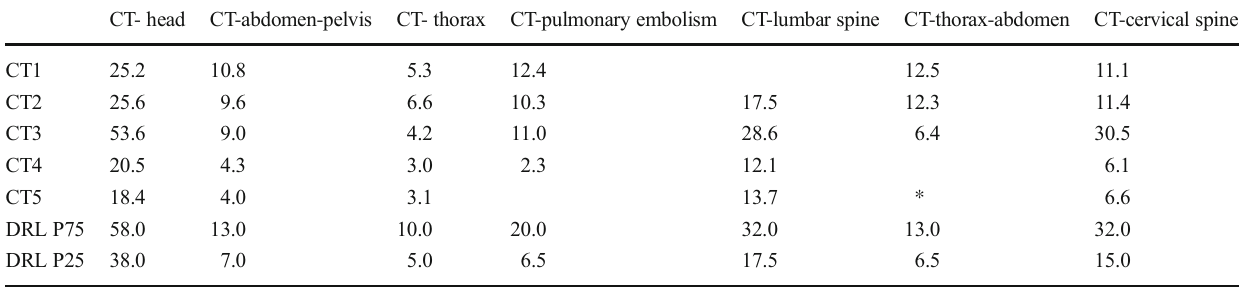
Median CTDI vol (mGy) per scanner for the different CT regions. P75 and P25 DRL levels of the nationwide survey as reference. *Separate protocols for the thorax and abdomen with different CTDI vol